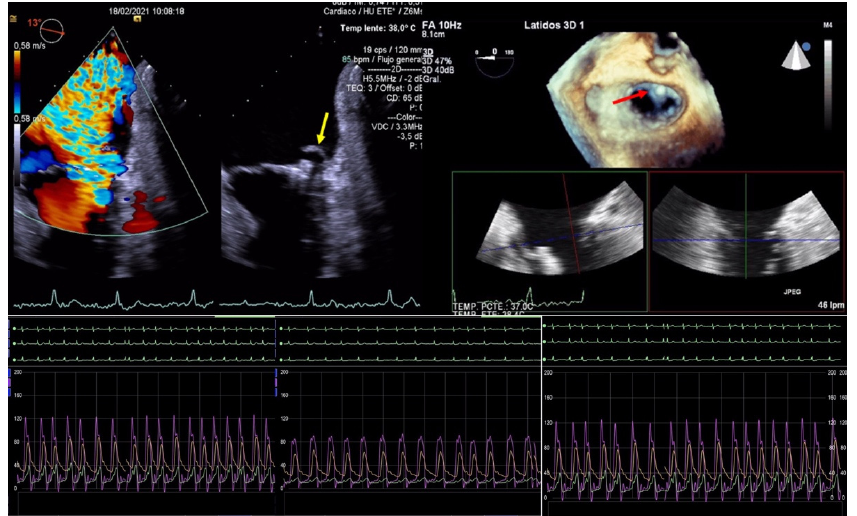
Figure 5. Two-dimensional transesophageal echocardiogram showing a very severe mitral regurgitation after the partial detachment of a clip and a leaflet tear prolapsing in the left atrium (yellow arrow). Three-dimensional transesophageal echocardiogram in the enface mitral view, where a clip can be seen attached to the anterior leaflet (red arrow) and loose from the posterior with a lack of diastolic tissue bridge. In the lower panel, simultaneous recording of left atrium (green), pulmonary artery (yellow), and aortic pressure (purple): baseline, post clip implantation and after detachment.